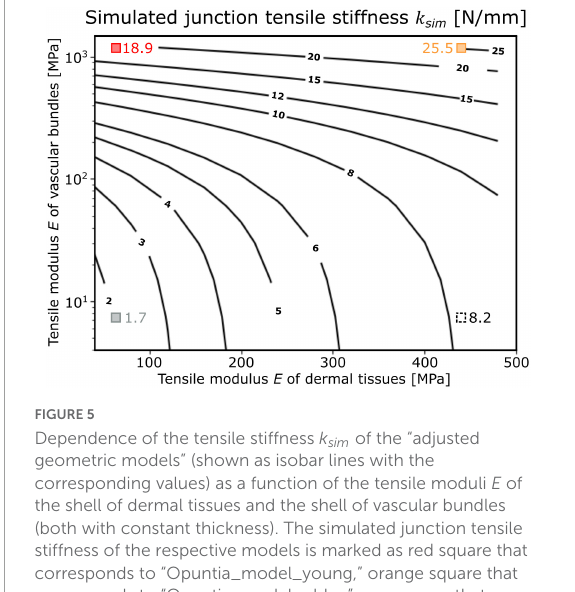
FIGURE5 Dependence of the tensile stiffness k sim of the “adjusted geometric models” (shown as isobar lines with the corresponding values) as a function of the tensile moduli E of the shell of dermal tissues and the shell of vascular bundles (both with constant thickness). The simulated junction tensile stiffness of the respective models is marked as red square that corresponds to “Opuntia_model_young,” orange square that corresponds to “Opuntia_model_older,” gray square that corresponds to “Cylindropuntia_model,” and black dashed square that corresponds to “Cylindropuntia_model” with a stiffened shell of dermal tissues and was only applied as a theoretical